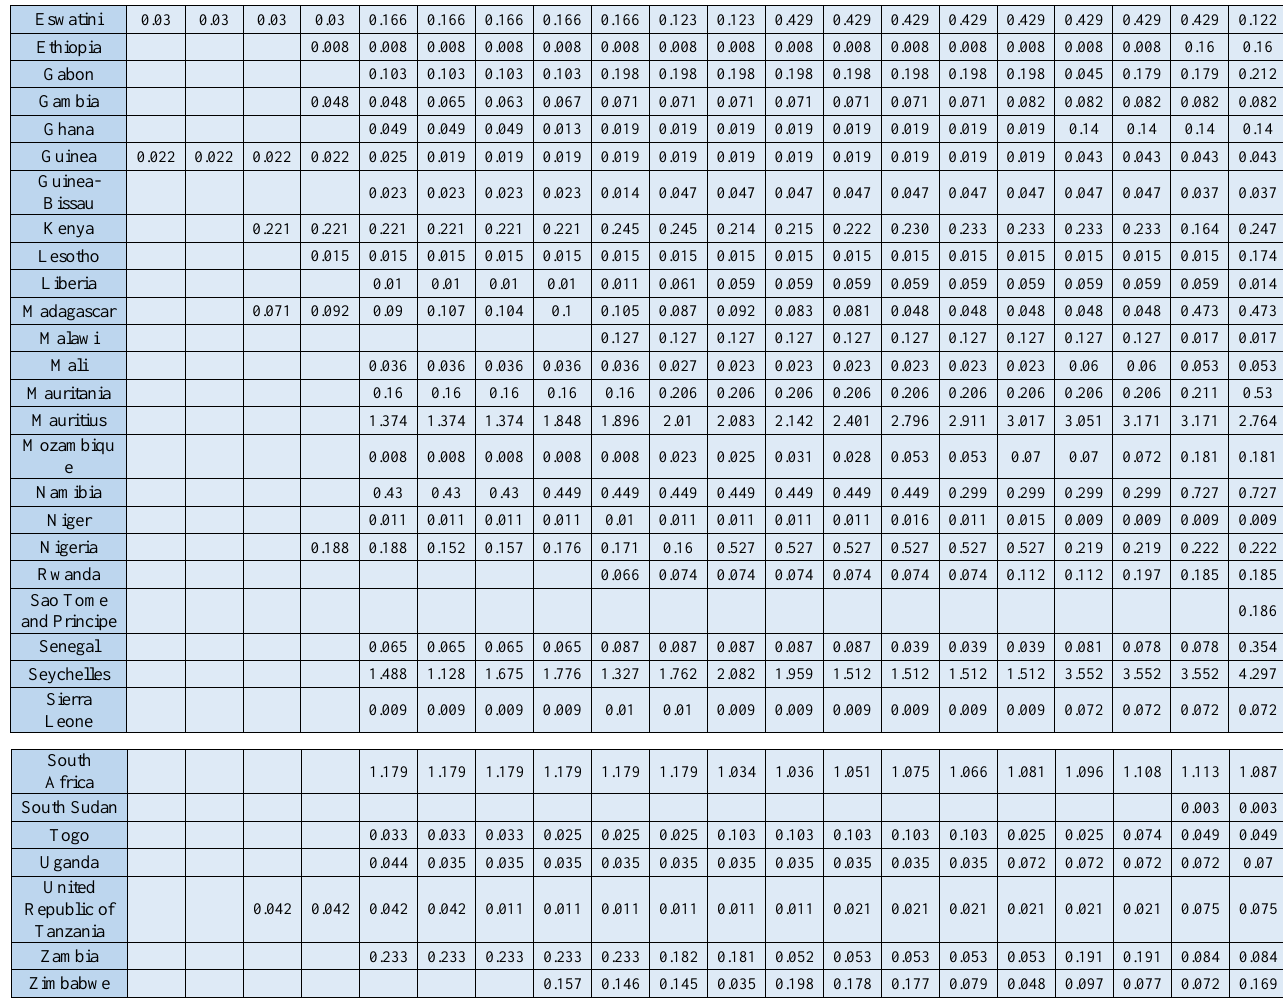
Source: The workforce data are based on the latest available data in the NHWA data platform as of 31 March 2021, apart from the data for 2019, which a combination of the latest available data from the NHWA data platform and King’s College London survey was used. Countries with the highest densities were named in the plot and highlighted in bold. Figure A1. Trends in density of dentists per 10,000 population for the AFR, 2000–2019.